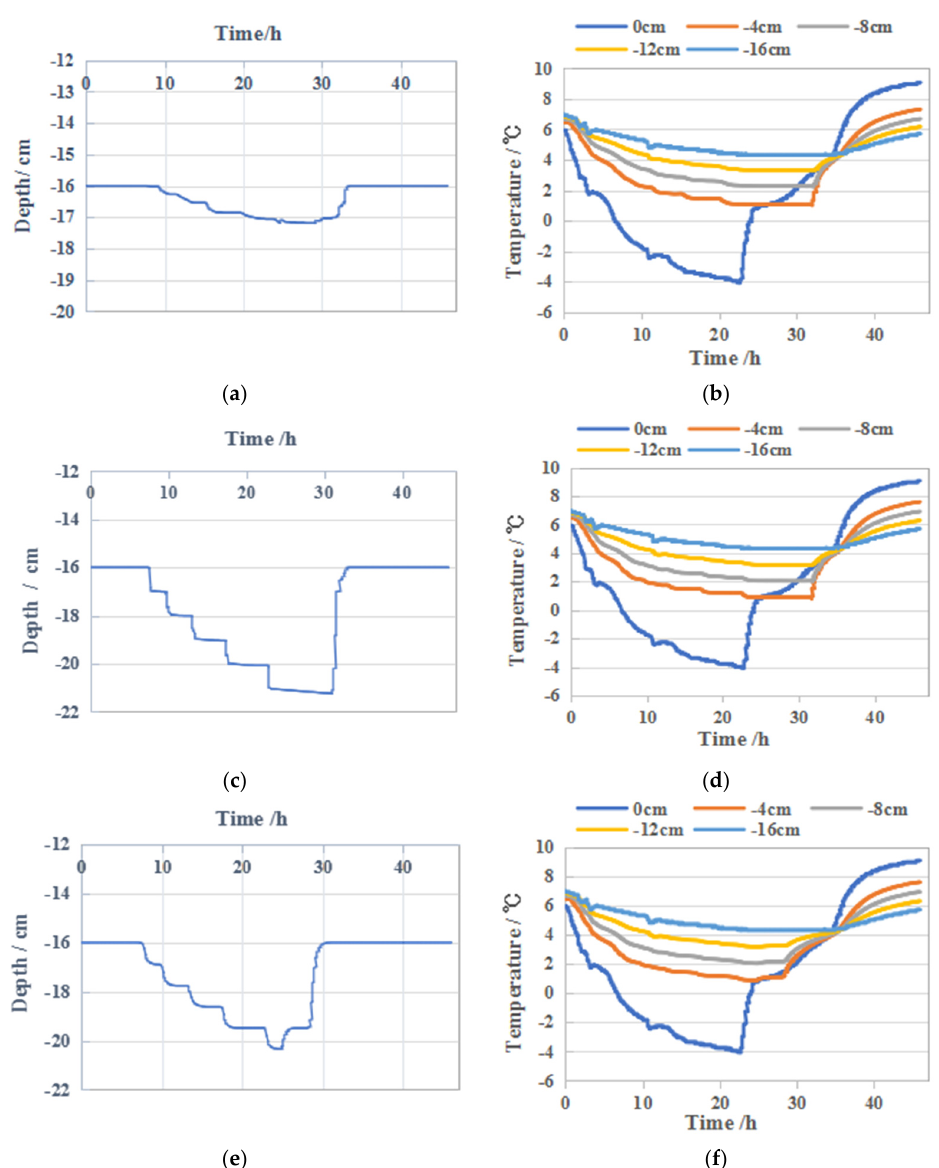
Figure 5. Comparison of water level and temperature changes obtained under various media. ( a ) Water level change and ( b ) temperature change obtained by the coarse sand model. ( c ) Water level change and ( d ) temperature change obtained by the fine sand model. ( e ) Water level change and ( f ) temperature change obtained by the silty clay